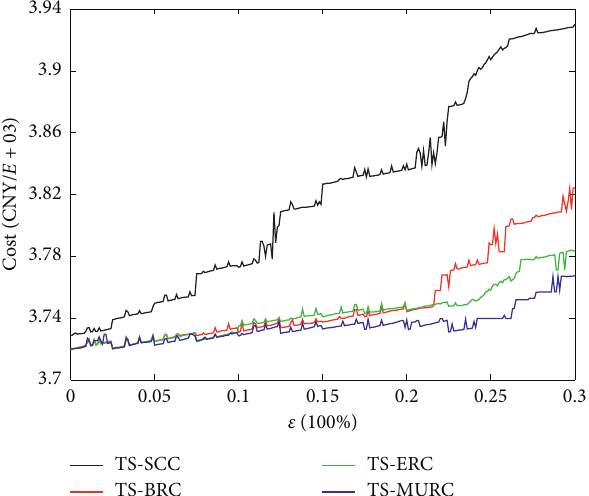
Figure 10: The influence of demand fluctuation on total cost.